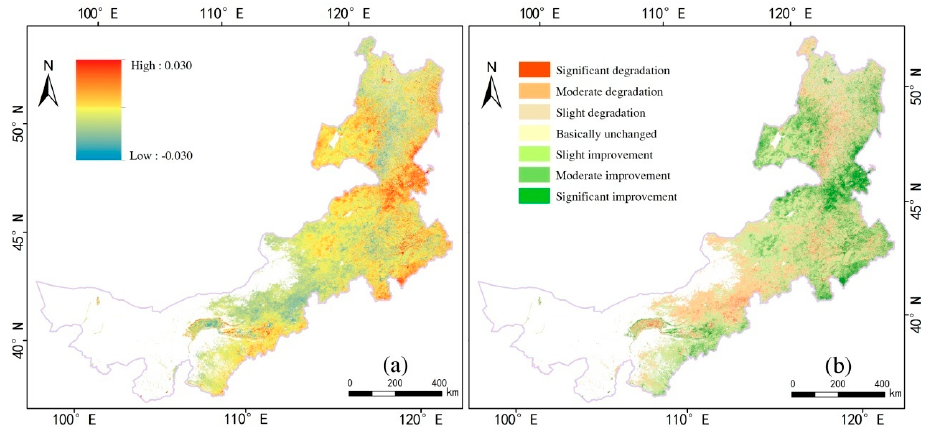
Figure 5. EVI trend ( a ) and EVI change ( b ) in the study area from 2000 to 2015.